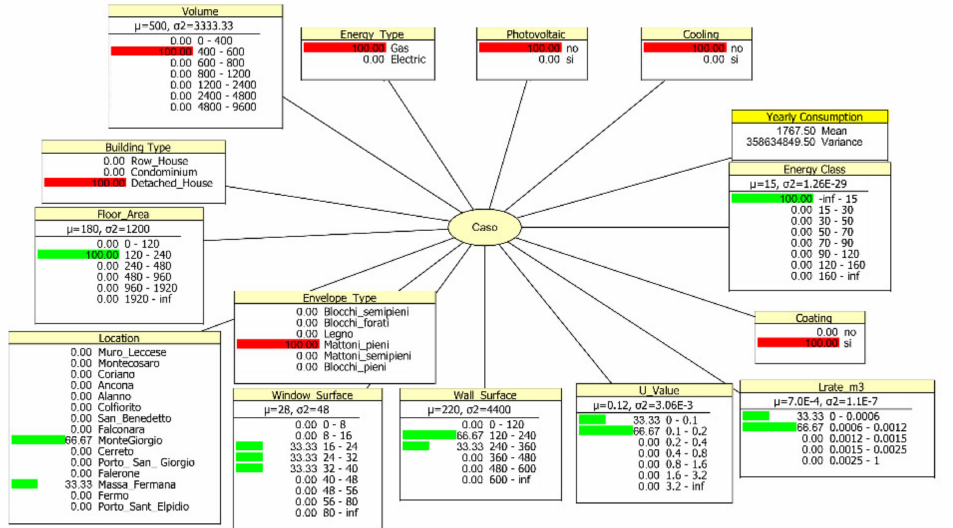
Figure 14. The index–frame used for scenario analysis (Coating = yes) relatively to the condition described in Figure